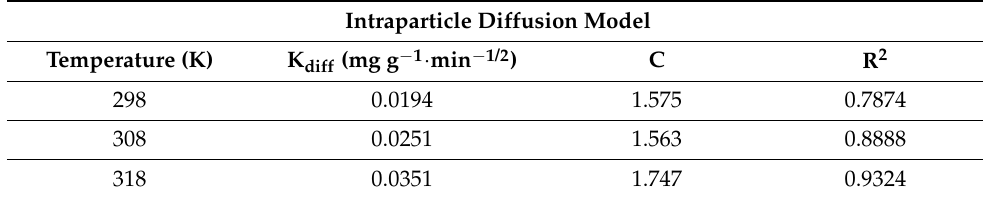
Table 4. Specific parameters obtained for intraparticle diffusion.